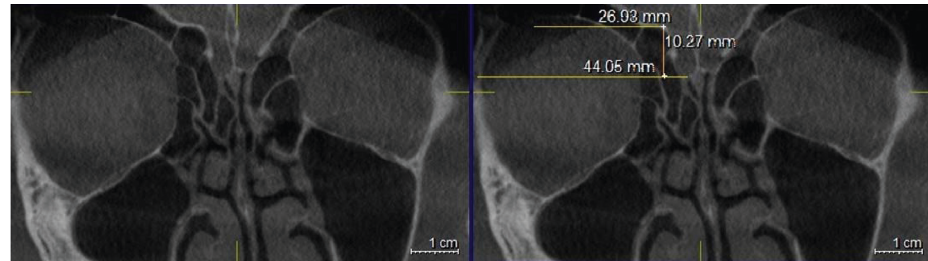
Figure 3: Coronal plan of CBCT demonstrating type 3 Keros classification on the right